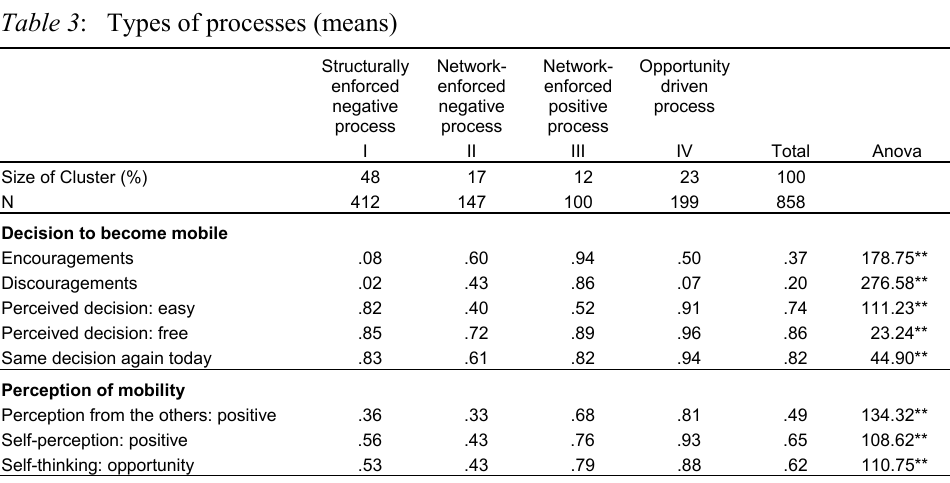
Table 3 : Types of processes (means)